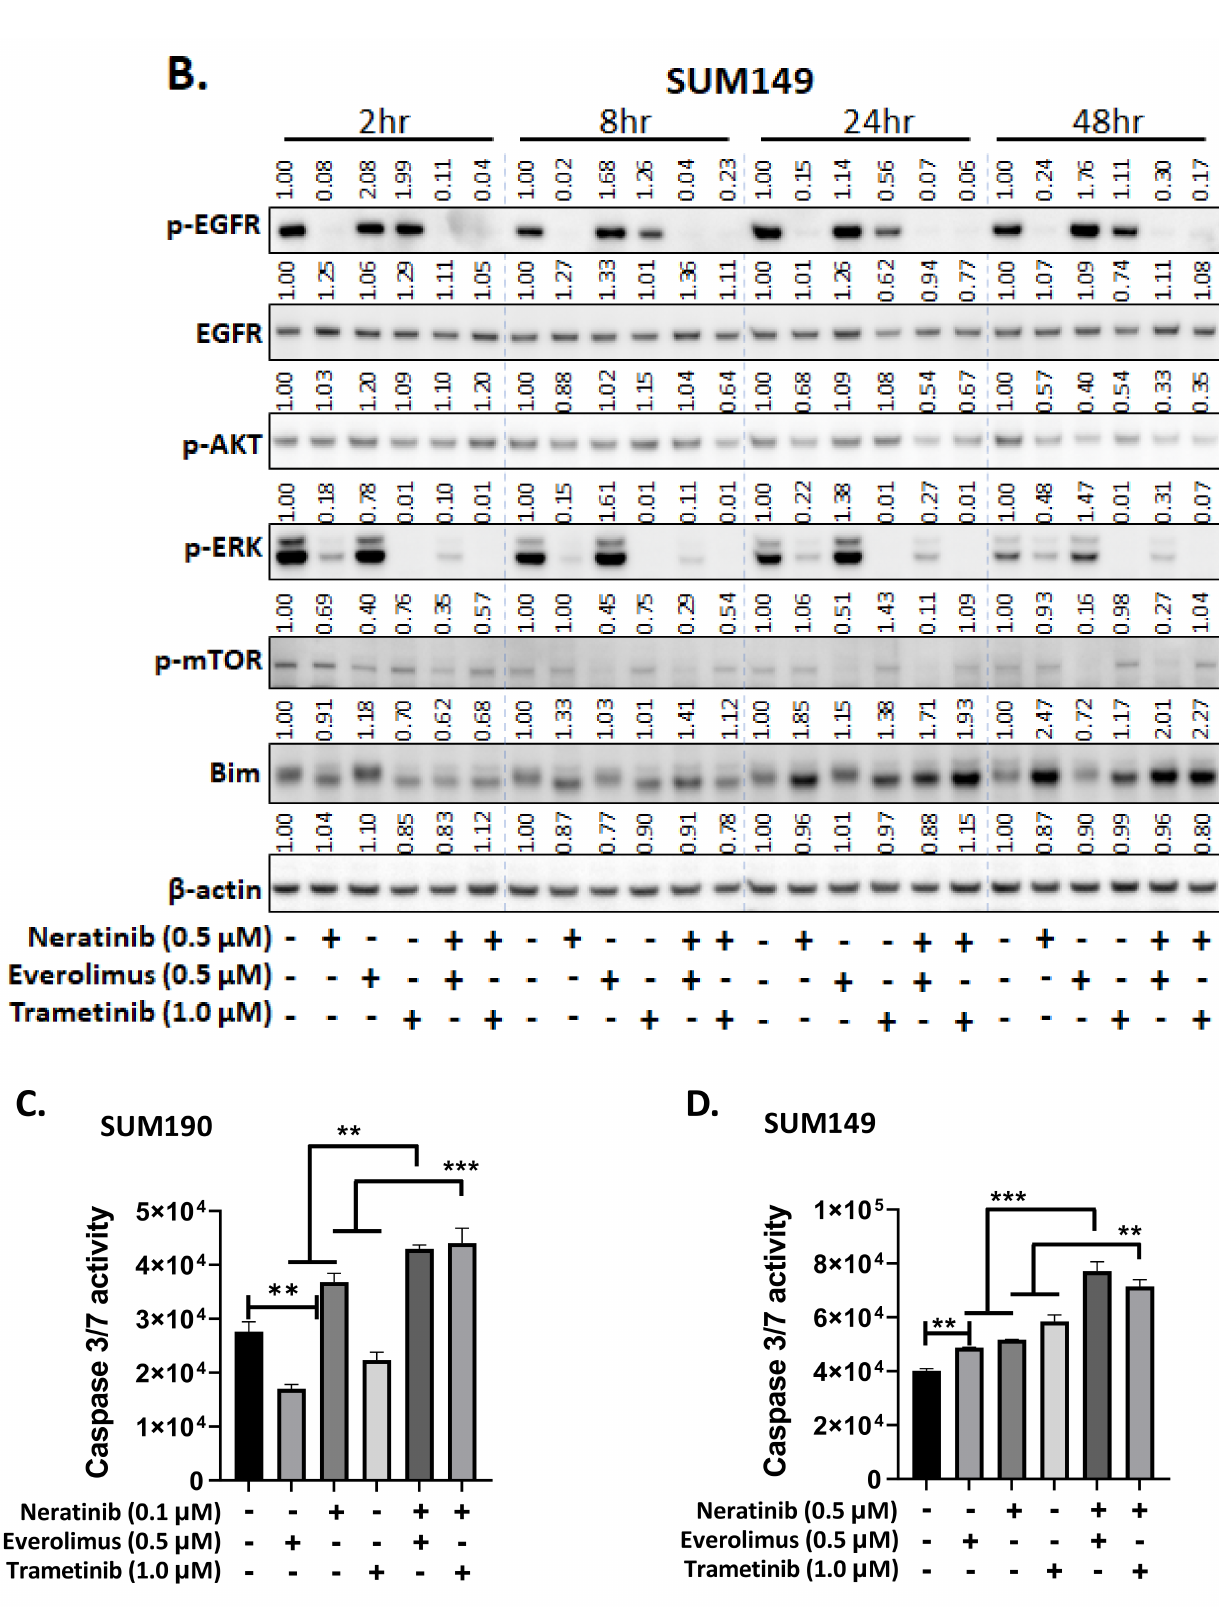
Figure 4. The combinatorial anti-proliferation effects of neratinib plus everolimus or trametinib were induced by apoptosis. ( A , B ). Western blotting results for SUM190 ( A ) and SUM149 ( B ) cells. ( C , D ). Caspase-Glo 3/7 assay of SUM190 ( C ) and SUM149 ( D ) cells. Cells were treated with the indicated drug for 16 h, and then caspase 3/7 activity was measured. Each box shows mean ± s.d; **, p < 0.01; ***, p < 0.001. Experiments were repeated in